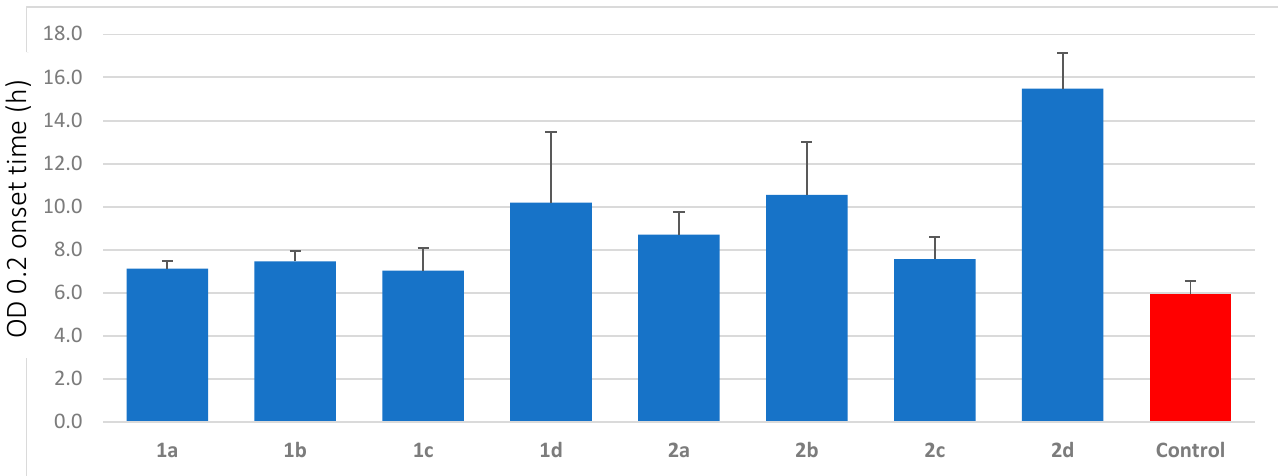
Figure 6. Certika assay with Au–SAM surfaces functionalized with peptides 1a – d and 2a – d as well as the control using the biofilm-forming bacterium S. epidermidis RP62A as a challenge. The diagram shows the OD 0.2 onset time in hours for all surfaces.